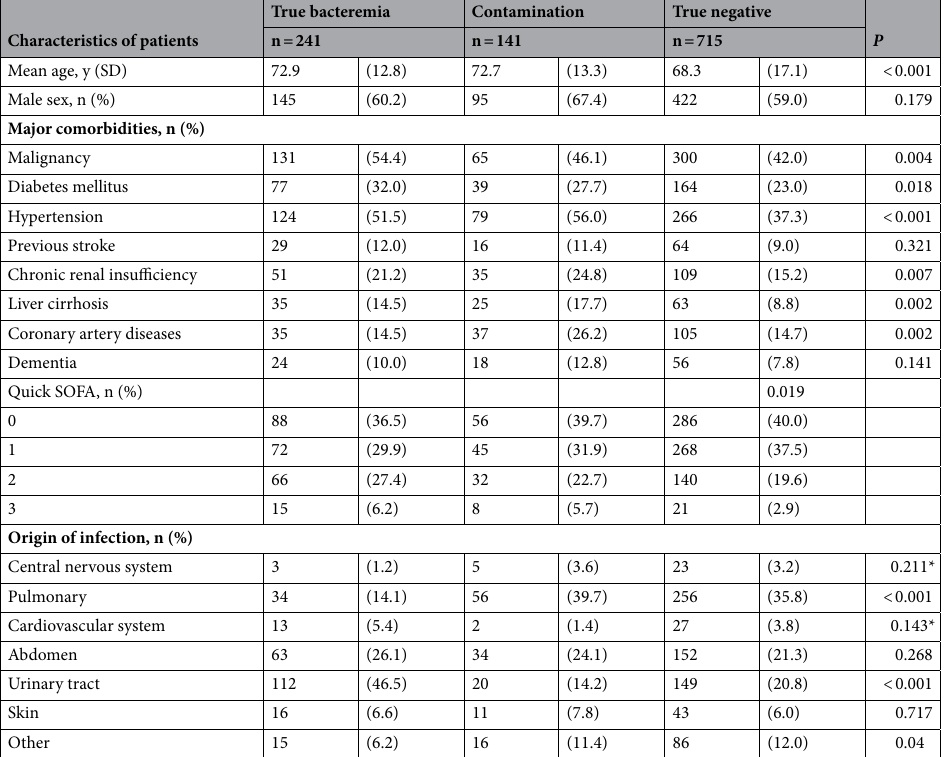
Table 1. Characteristics of enrolled patients. SD, standard deviation; SOFA, sequential organ failure assessment. *Fisher exact test was performed because of small number of patients in several cells; other groups were analyzed using two-tailed χ 2 test and one-way analysis of variance (ANOVA). Origin of infection means the cause of infection, as judged based on medical chart review including other cultures and various diagnostic modalities. Central nervous system included meningitis, encephalitis, and brain abscess. Pulmonary included pneumonia, bronchitis, pleuritis, and upper respiratory infection. Cardiovascular system included endocarditis and pericarditis. Abdomen included cholangitis, gastroenteritis, cancer of gastrointestinal tract, hepatitis, cholecystitis, appendicitis, and pancreatitis. Urinary tract included pyelonephritis, cystitis, and prostatitis. Skin included decubitus, cellulitis, impetigo, and erysipelas. Other included febrile neutropenia and cases in which the source of infection could not be